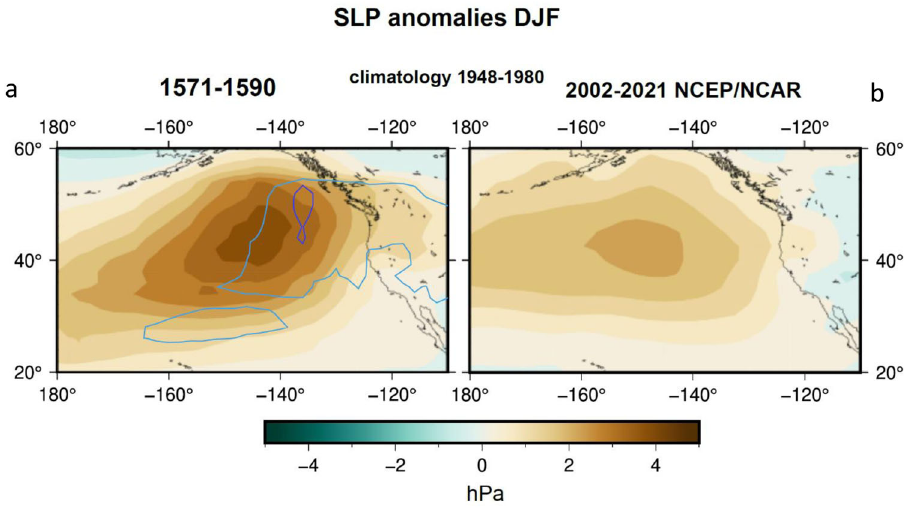
Fig. 7 Circulation pressure conditions associated with early (1571-1590) and current (2001-2021) Southwest drought periods. Boreal winter (DJF) SLP composite anomalies for the northeastern Paci fi c and western coastal North America for a early (RECON) and b current (INST) drought periods. Climatology period for anomaly calculation is 1948 – 1980 (the period of overlap between the RECON and INST data) and the mean and standard deviation of RECON data were set to match those of INST during this period to facilitate cross-comparison of the composites. Blue/dark blue contours indicate signi fi cance of the differences between the composites at p ≤ 0.2/ p ≤ 0.1 levels, using a 1-sided, inhomogeneous variance t